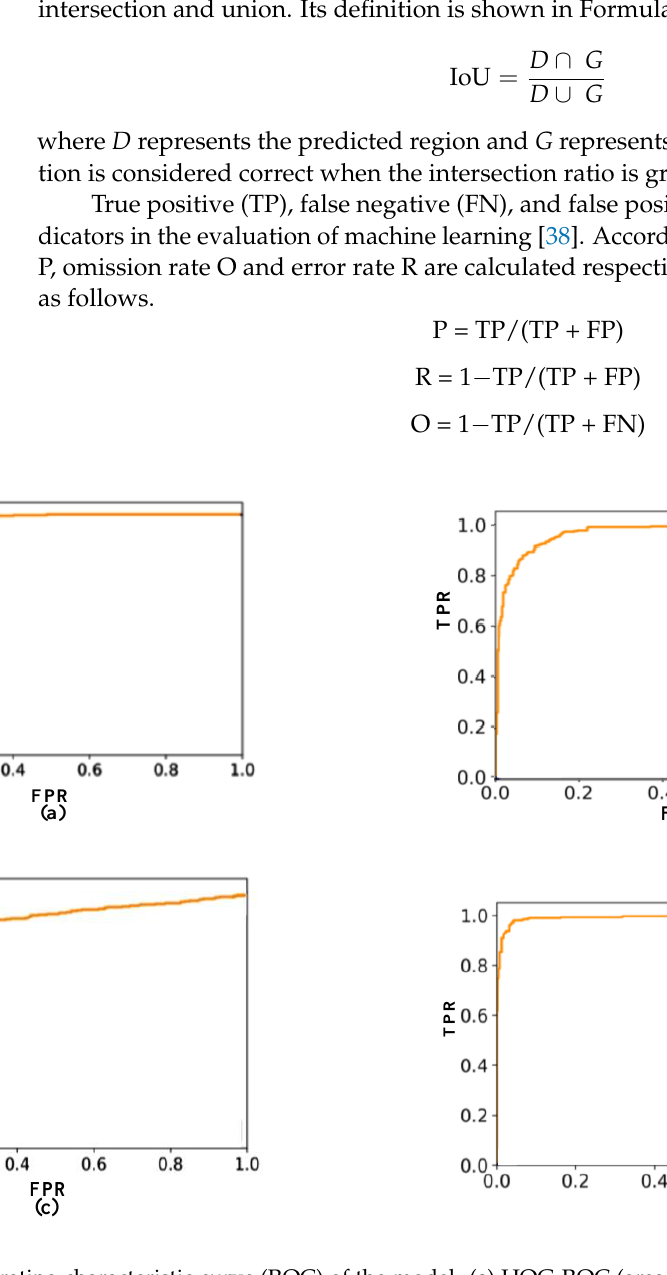
Figure 11. Receiver operating characteristic curve (ROC) of the model. ( a ) HOG-ROC (area = 0.976), ( b ) LBP-ROC (area = 0.969), ( c ) Haar-ROC (area = 0.913), ( d ) multifeature-ROC (area =